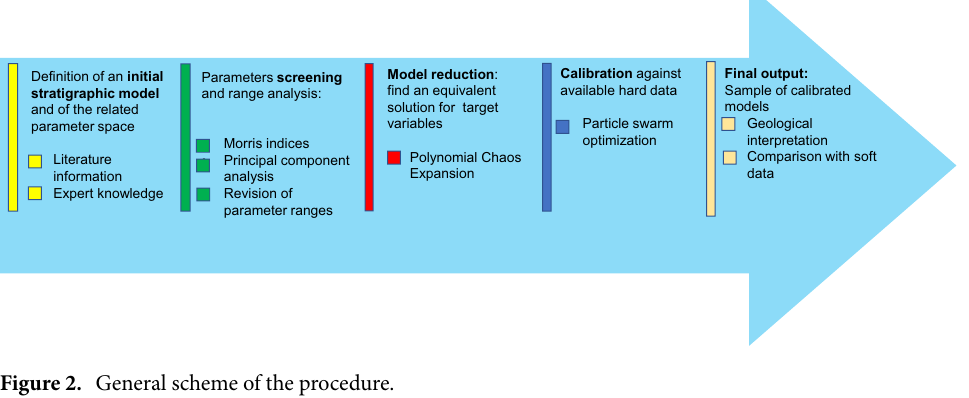
Figure 2. General scheme of the